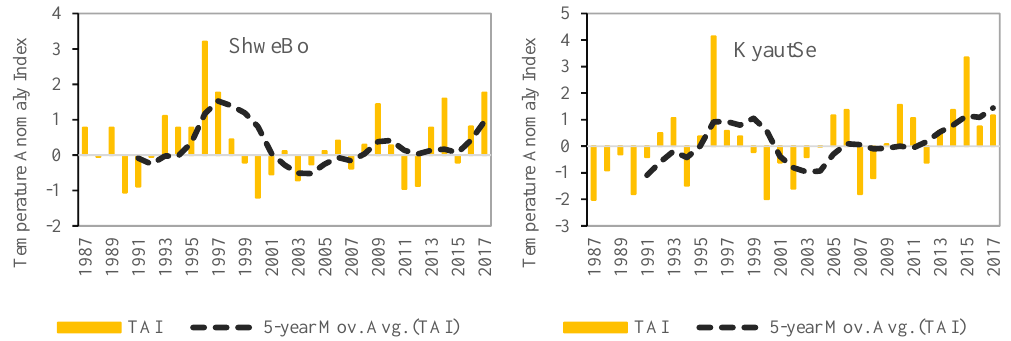
Figure 5. Temperature anomaly index (TAI) and five-year moving average for ShweBo and KyautSe, from 1987 and 2017.